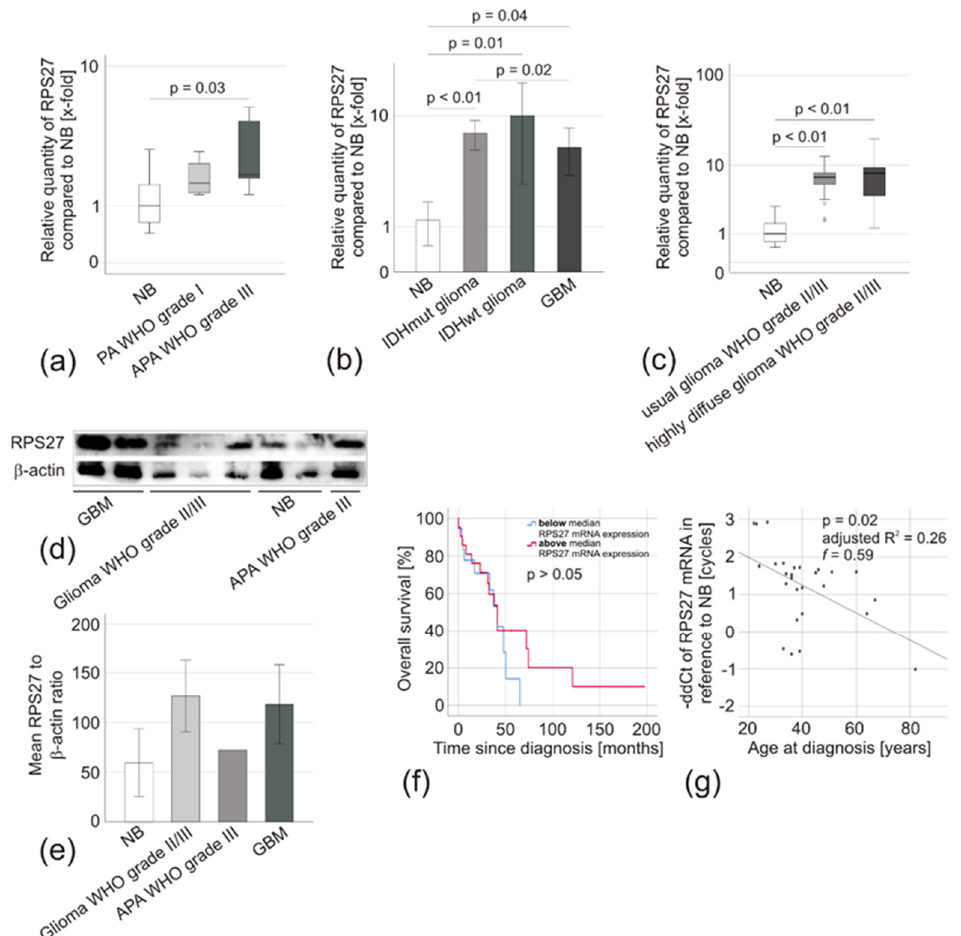
Figure 6. RPS27 expression in glioma specimens. ( a ) Box-plot of RPS27 mRNA expression in pilocytic astrocytoma WHO grade I (PA, n = 4) and anaplastic PA WHO grade III (APA, n = 5) compared to NB ( n = 8). The median is displayed by the middle line, the quartiles are represented by the hinges, extreme values up to 1.5 times the height of the box are shown by whiskers. Differences of ddCt-values were compared by ANOVA, Leven’s test used to assess the equality of variances, and Scheffe procedure or Dunnet T3 chosen as posthoc tests. ( b ) Relative RPS27 mRNA expression compared to NB ( n = 8). (IDHmut glioma n = 28, IDHwt glioma n = 13, GBM n = 76). ( c ) Box-plot of RPS27 mRNA expression in usually growing (infiltration into 1-3 lobes, n = 17) and highly diffuse (infiltration into > 3 lobes) gliomas WHO grade II/III ( n = 41) compared to NB ( n = 8). ( d ) Western blot of randomly selected samples of each tumor entity and ( e ) quantification by densitometry in relation to the housekeeping gene β -actin. The unchanged original blots are shown in Figure S3. ( f ) Kaplan–Meier analysis comparing the overall survival of WHO grade II/III glioma patients with RPS27 mRNA expression below (blue, n = 21) and above (red, n = 20) the median expression of 7.9-fold by Breslow test. ( g ) Scatter diagram of RPS27 mRNA expression compared with the age of WHO grade II/III glioma patients. Linear regression, p-value based on ANOVA, effect size based on Cohen’s f. IDHmut glioma and IDHwt glioma were combined for the analyses presented in ( c ), ( d ), and ( e ).